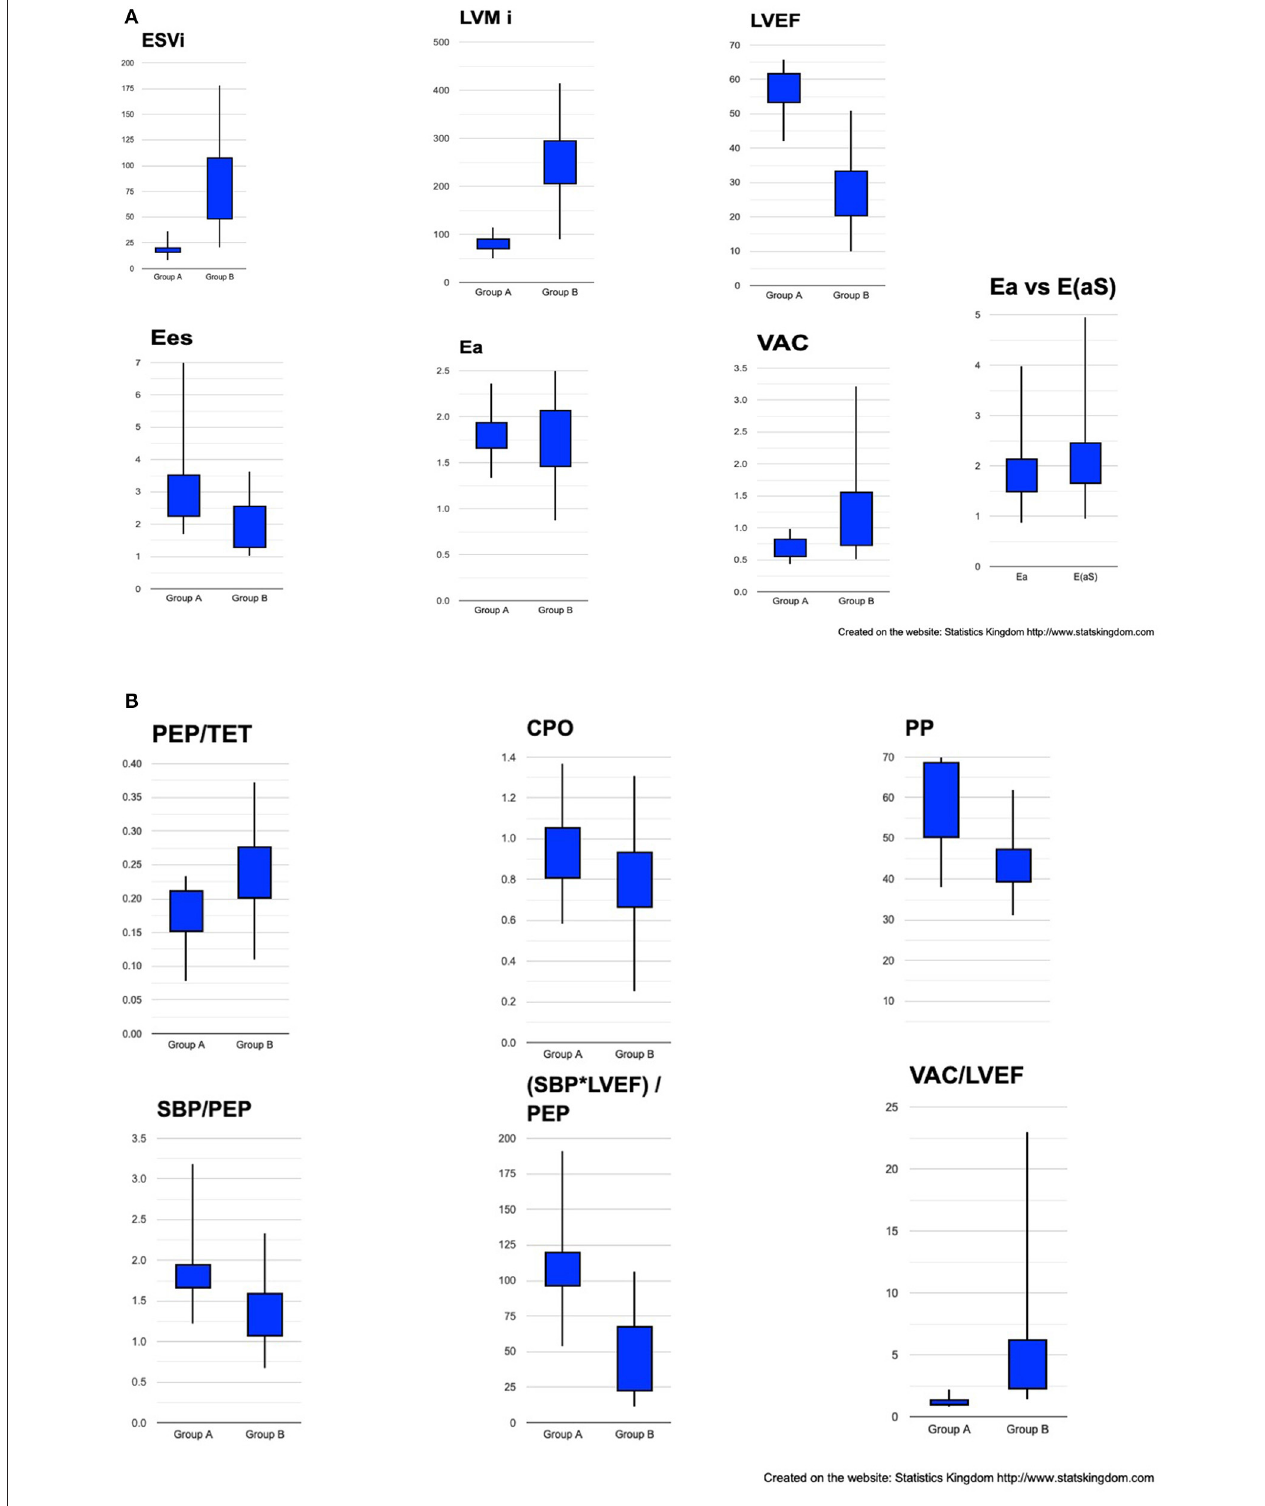
FIGURE 5 | Box plot representation of cardiac structural and hemodynamic parameters among groups. (A) ESVi, LVMi, LVEF, Ees, Ea, VAC, Ea vs. E(aS). (B) PEP/TET, CPO, PP, SBP/PEP, (SBP*LVEF)/PEP, VAC/LVEF. ESVi, indexed LV end-systolic volume; LVMi, indexed LV mass; LVEF, LV ejection fraction; Ees, ventricular elastance; Ea, effective arterial elastance; VAC, ventricular-arterial coupling; E(aS), arterial elastance calculated by Segers formula; PEP, pre-ejection period; TET, Total ejection time; CPO, cardiac power output; PP, pulse pressure; SBP, systolic blood pressure.